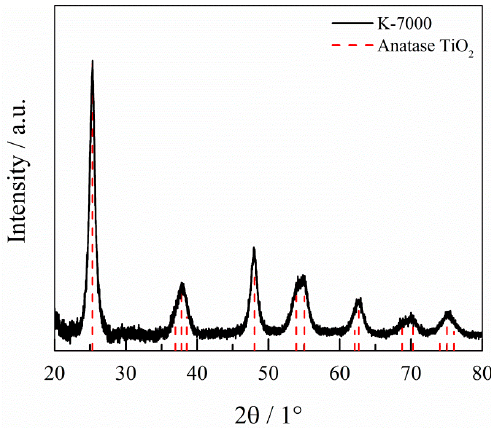
Figure 1. XRD pattern of K-7000 and the anatase reference JCPDS card No. 21-1272.